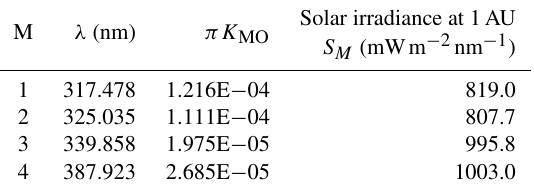
Table 2. πK M on 1 January 2016.